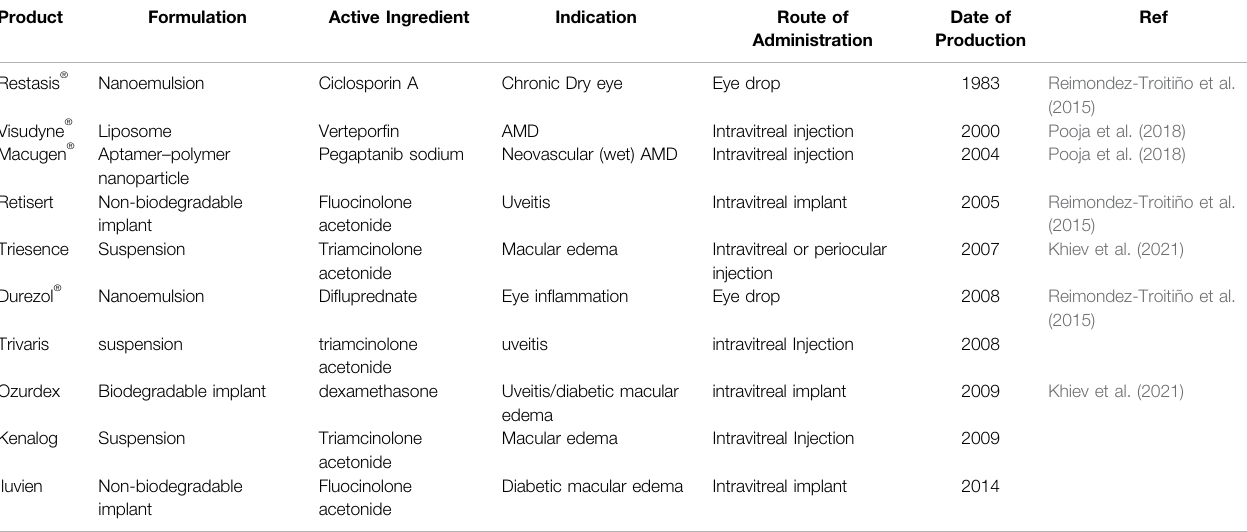
TABLE 4 | FDA approved nanomedicine applied in ocular